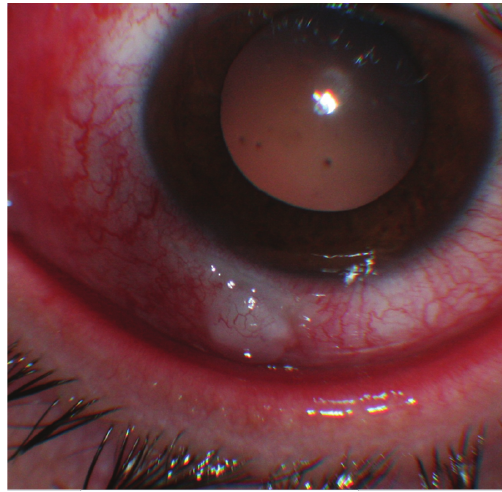
Figure 2: An unintentional conjunctival bleb at 7 o’clock.